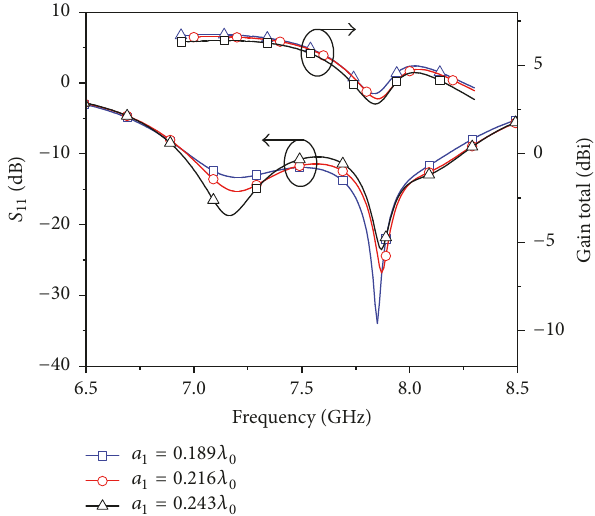
reflection mechanism is sketched in Figure 9 considering five different regions as follows: region-P/R/T is filled with air ( 𝜀 𝑝 = 𝜀 𝑟 = 𝜀 𝑡 = 1 ) with loss factor tan 𝛿 𝑝 = tan 𝛿 𝑟 = tan 𝛿 𝑡 = = 𝜀 = 4.4 ) with loss 0 and region-Q/S is dielectric sheet ( 𝜀 𝑞 𝑠 factor tan 𝛿 𝑝 = tan 𝛿 𝑠 = 0.02 . When input is given through microstrip feed line, some energy couples into the cylindrical DR through the slot and some other energies (say 𝐸 𝑟 ) are released into region-R, then move in - Z direction, and face multiple reflections at Interface-RS and